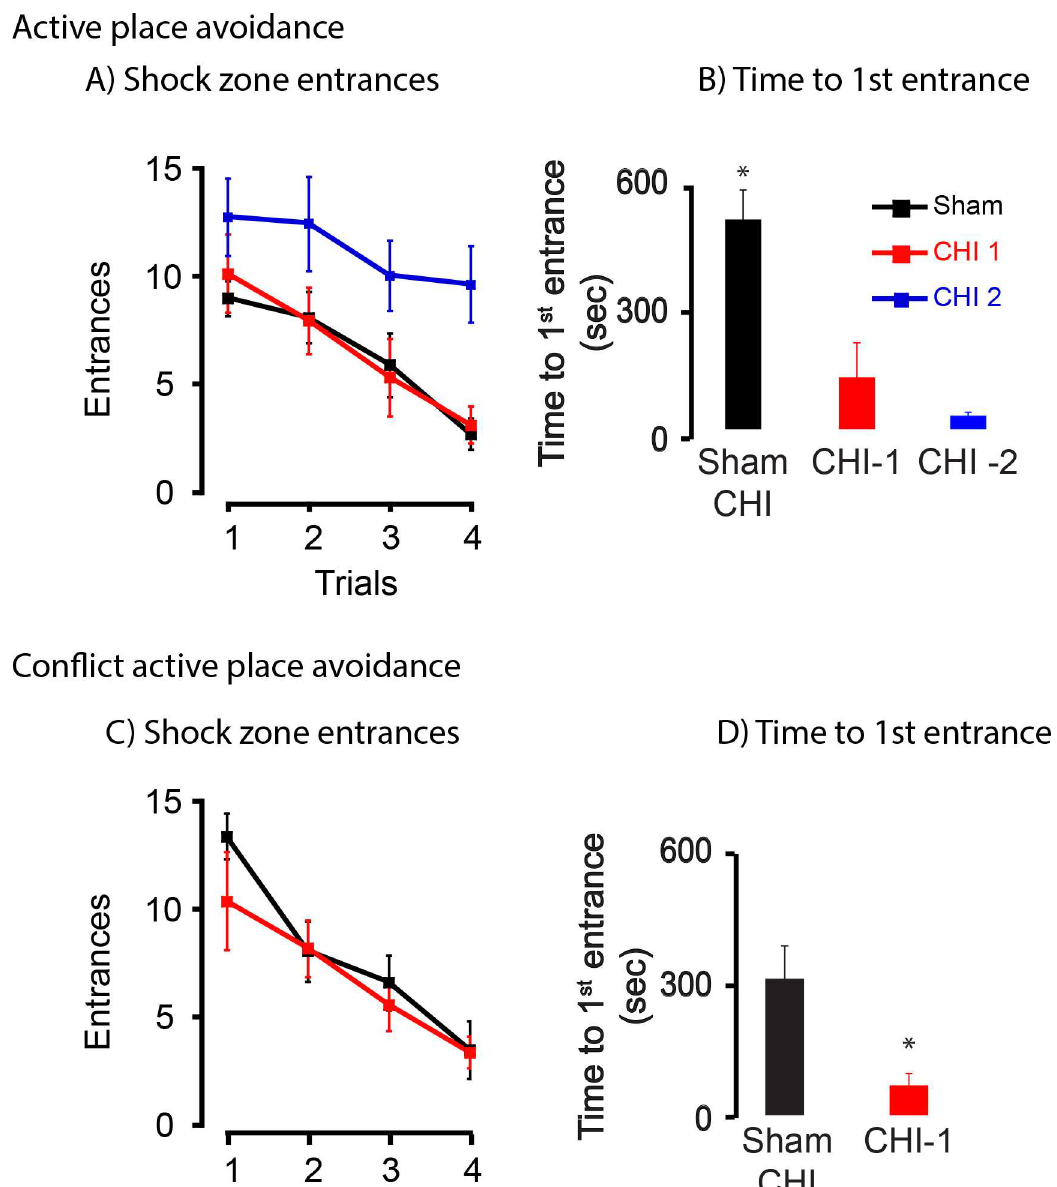
Fig 4. CHI-1 and CHI-2 mice retain behavioral deficits one month after injury. Panel A, Summary of active place avoidanceone month after injury. Active place avoidanceat one month post-injury showed a significant interaction between group and trial (F 6,51 = 6.06, p < 0.0005). The sham-CHI and CHI-2 groups significantly differed between the sham-CHI and CHI 2 (post-hoc, p = 0.001). The CHI 1 group strongly trended toward differing from the CHI 2 group (p = 0.056). Panel B, Sham-CHI mice had a significantly longer time to 1st entrance than CHI-1 or CHI-2 mice (post hoc * p < 0.01). Panel C, At 1 month, number of entrances for conflict active place avoidance,group and trial did not statistically interact (F 1764,39 ) = 0.662, p = 0.51). The two groups had a similar number of entrances(F 1,13 = 0.136, p = 0.72). On the final trial of conflict active place avoidance, sham-CHI and CHI-1 mice had a similar number of total entrances (t 10 = 0.3, p > 0.5), but differed significantly on time to 1st entrance (t 10 = 2.98, * p <